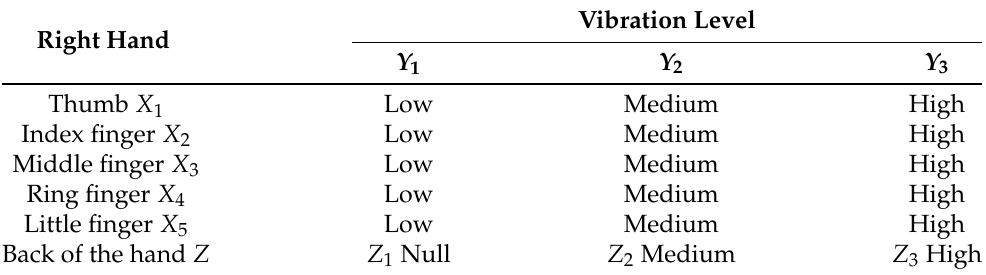
Table 1. Detail of motor